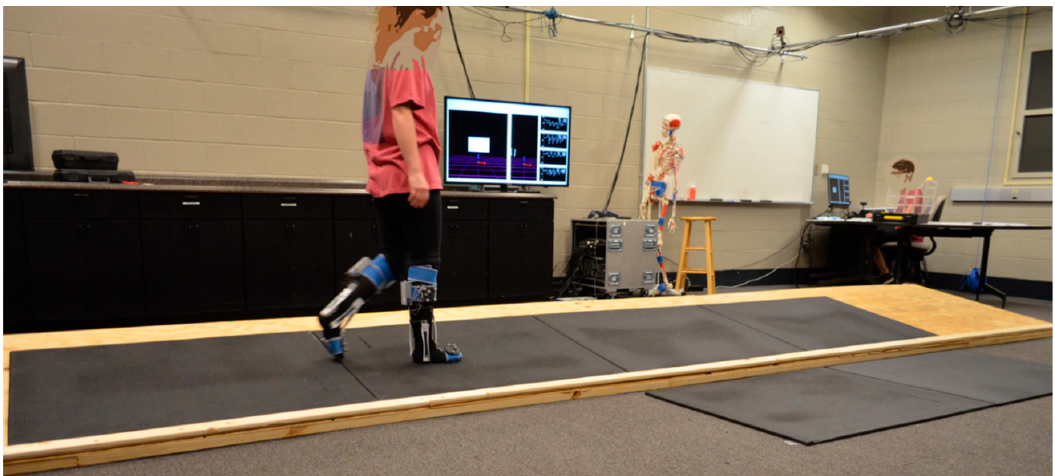
Figure 1. A 1.22 m wide by 7.32 m long tilted surface platform or TSP walkway with 10-degree slope for inducing inversion (INV) and eversion (EVR) foot-ankle complex movements during self-paced gait trials; includes 6.10 m of covered half-inch rubber mats; simulated participant trial during TSP right-foot INV and left-foot EVR.